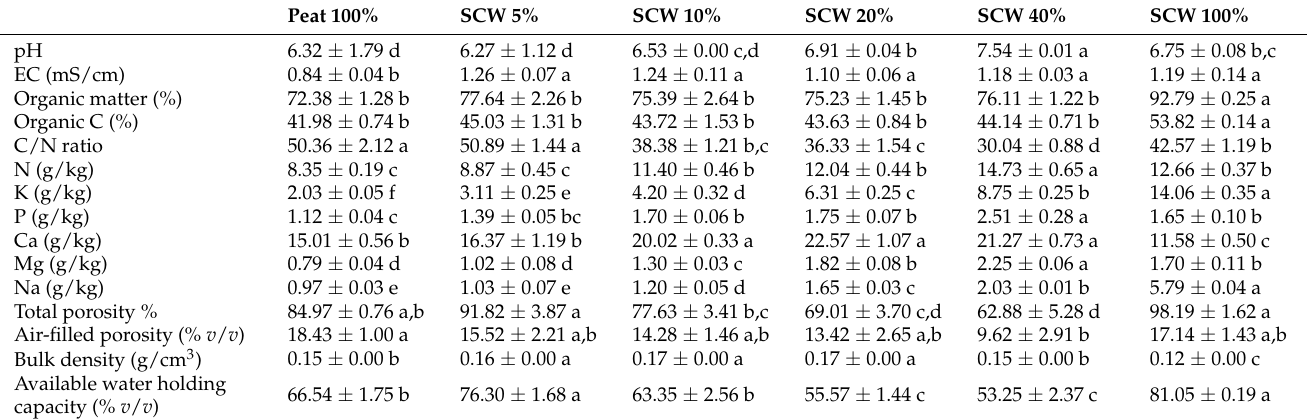
Total porosity (TP), available water holding capacity (AWHC), air-filled porosity (AFP), bulk density (BD) by volume. Values are mean ± SE ( n = 4). In each row, values followed by the same letter do not differ significantly, according to Duncan’s multiple range test at p < 0.05. Table 2. Growing media (peat, Sideritis cypria waste—SCW) physicochemical properties before plant